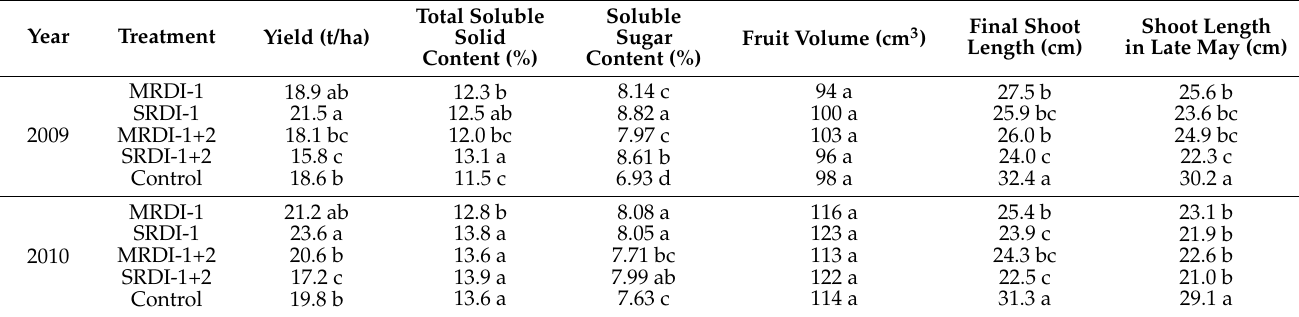
Figure 5. The leaf photosynthetic rate in three growing stages. Each value is the mean value measured over three days during each stage. Different lower letters within the same stage indicate significant differences between various treatments at the p < 0.05 level. Vertical bars represent one standard deviation of the mean. MRDI-1 and SRDI-1 were applied with moderate and severe water stress, respectively, during Stage 1 (0–30 DAB), and fully irrigated during other stages; MRDI-1+2 and SRDI-1+2 were applied with moderate and severe water stress, respectively, during Stage 1+2 (0–86 DAB), and fully irrigated during other stages. Table 2. Yield, fruit quality, and shoot length of each